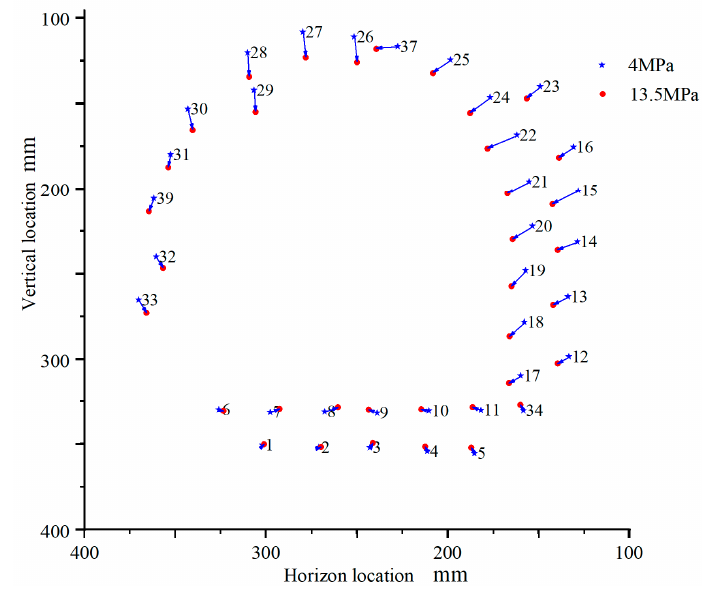
Figure 5. Comparison of position changes of monitoring points.